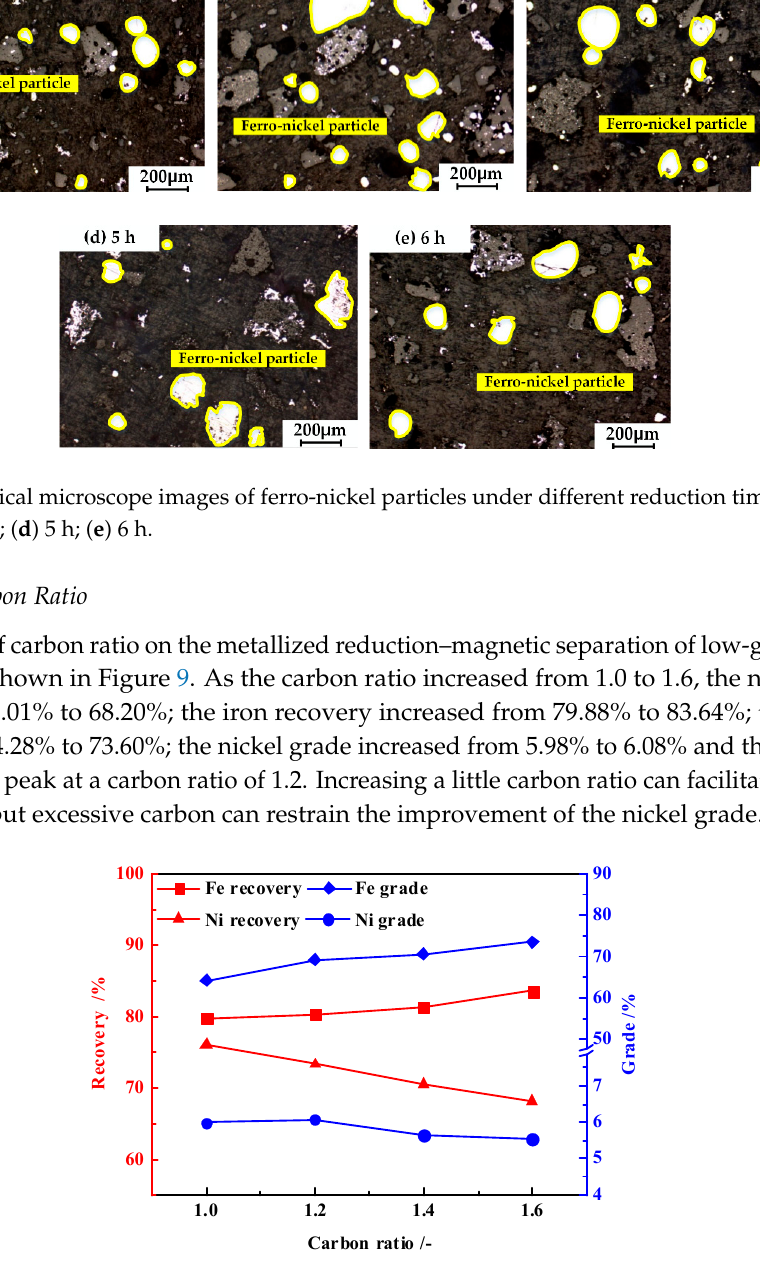
Figure 9. Effects of carbon ratio on grades and recoveries of Ni and Fe.